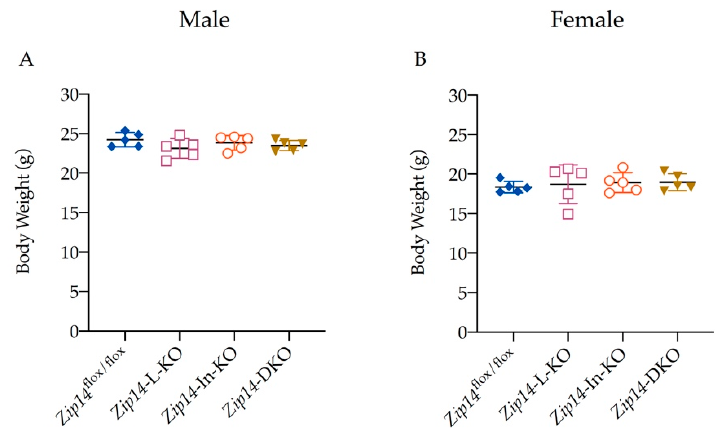
Figure 2. Deletion of ZIP14 in the intestine and/or liver did not affect the body weight in mice. Body weights of the 9-week-old control, Zip14 -In-KO, Zip14 -L-KO, and Zip14 -DKO mice were plotted. ( A ) Male mice ( n = 5). ( B ) Female mice ( n = 5). Data were expressed as mean ± standard deviation (SD). Statistical analysis was performed using one-way analysis of variance (ANOVA) followed by the Bonferroni post-hoc test. No significant differences were found between these groups.